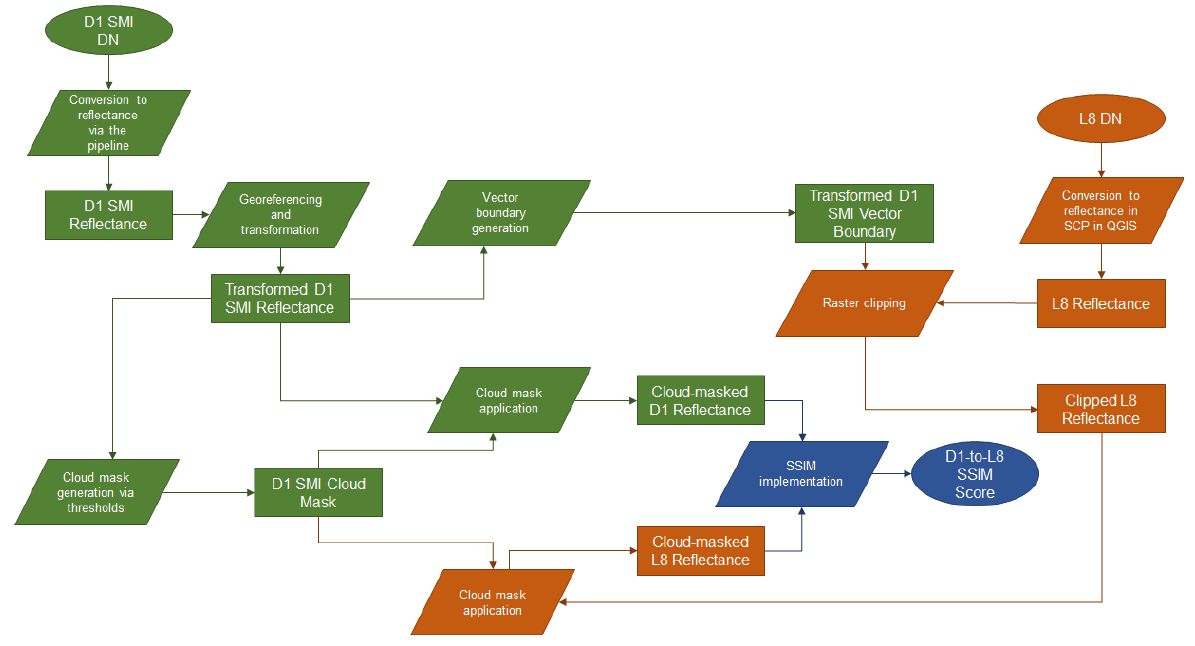
Figure 1 . Flowchart of this study’s